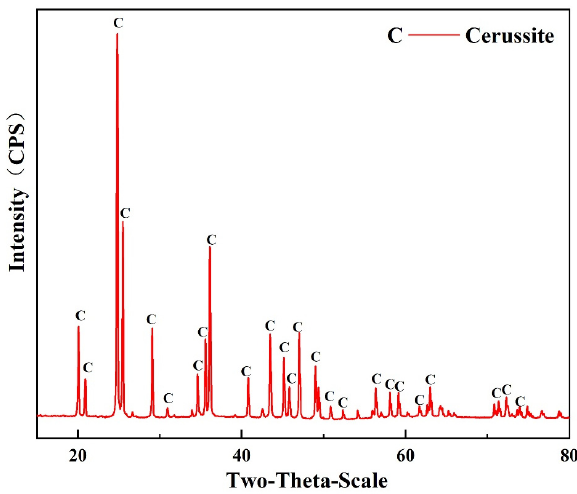
Figure 1. XRD pattern of the cerussite sample used in this study.